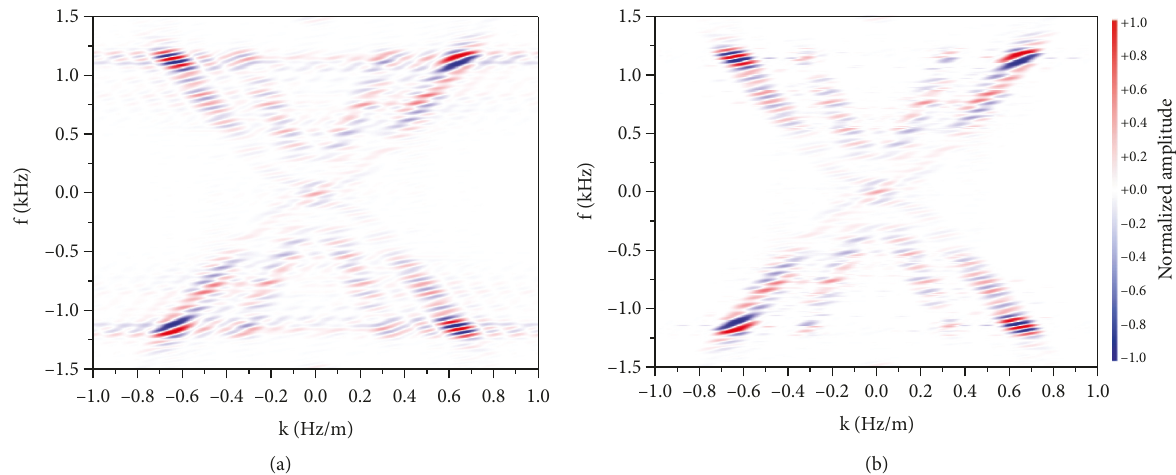
Figure 2: Raw data in the f-k domain before (a) and after (b) eliminating the spatial alias frequency signal. (a) Raw data in the f-k domain. (b) Data in the f-k domain after elimination.